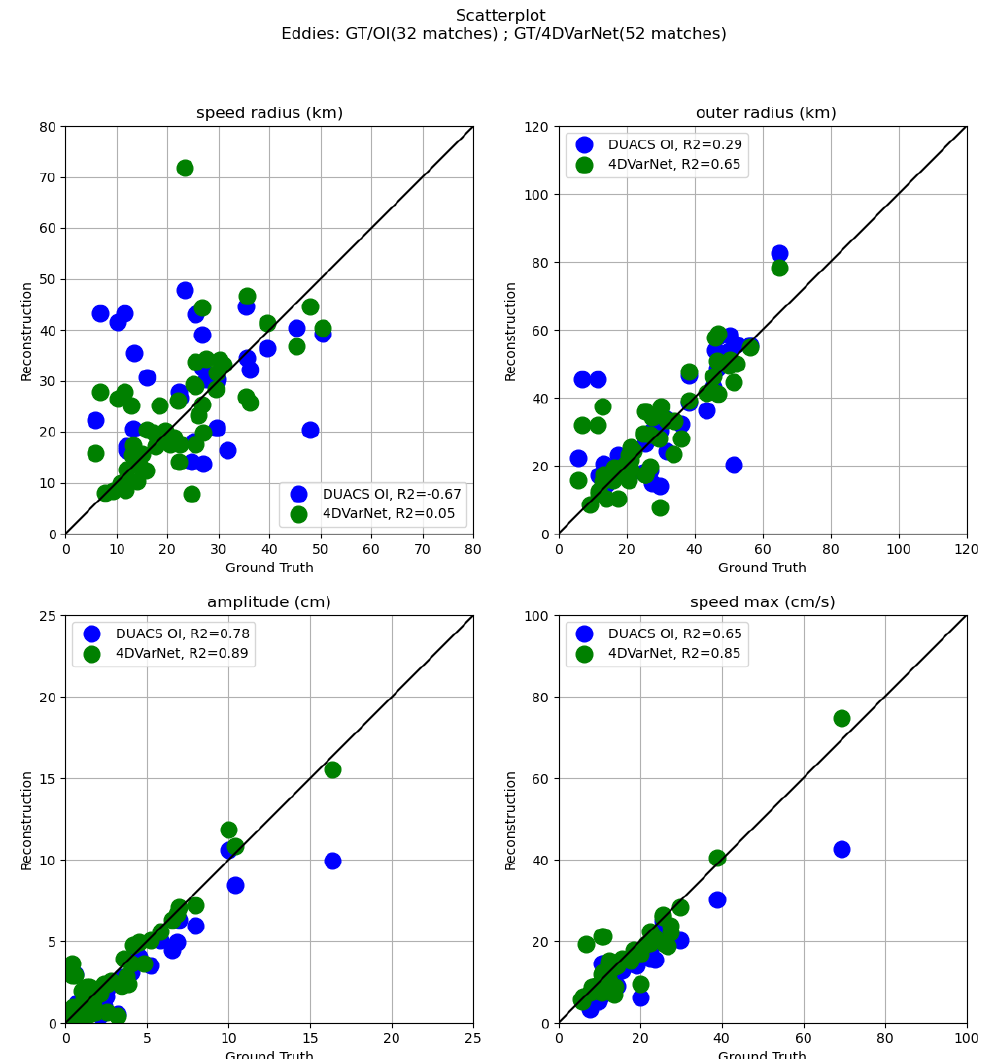
Figure C6. Speed radius (km), outer radius (km), amplitude (cm), and speed max (cms − 1 ) scatterplots of 4DVarNet/DUACS OI (one SWOT plus four nadirs) vs. ground truth on the OSMOSIS domain (25 October 2012) for matching